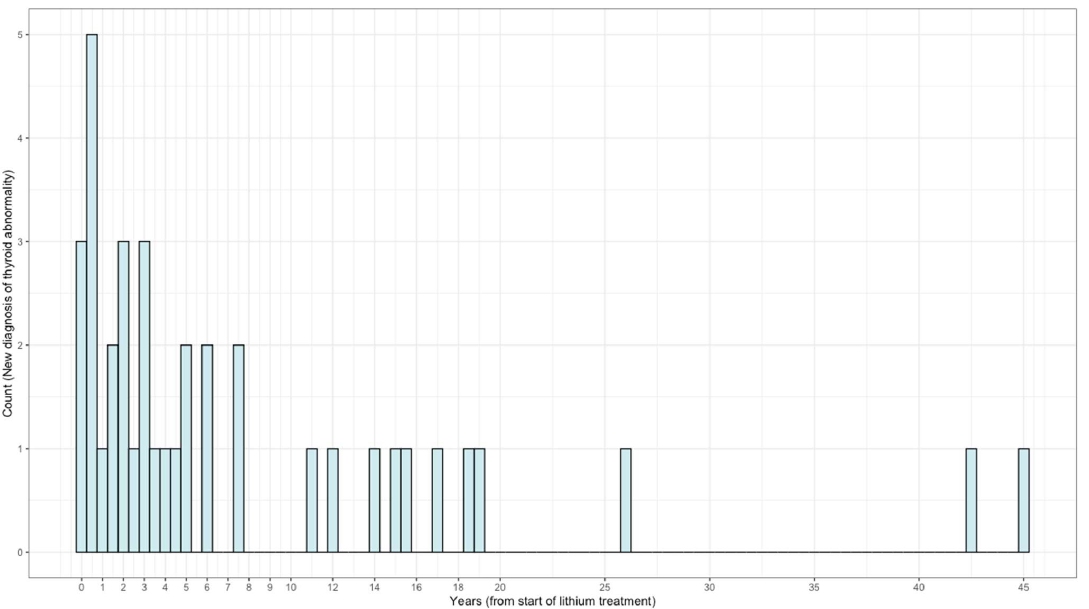
Figure 2. Frequency distribution of diagnosis of new thyroid abnormality during lithium treatment (N = 38).